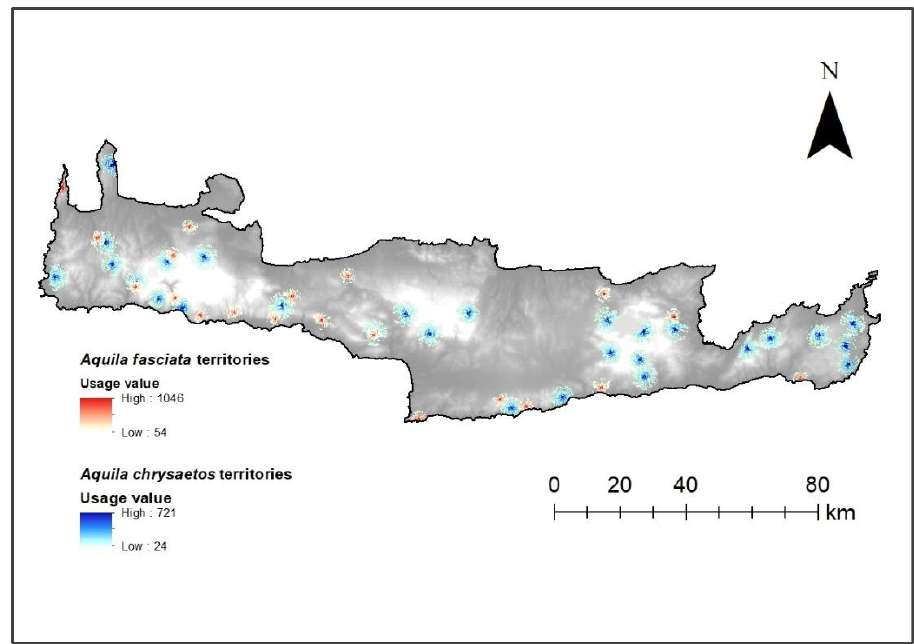
Figure 1. Distribution of active and overlapping Golden and Bonelli’s eagle territories in Crete.